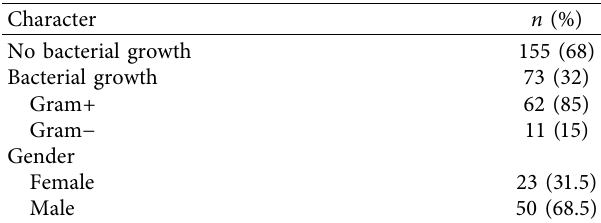
Table 1: Ocular infection distribution of bacteria isolates among pediatric patients with gender and age.